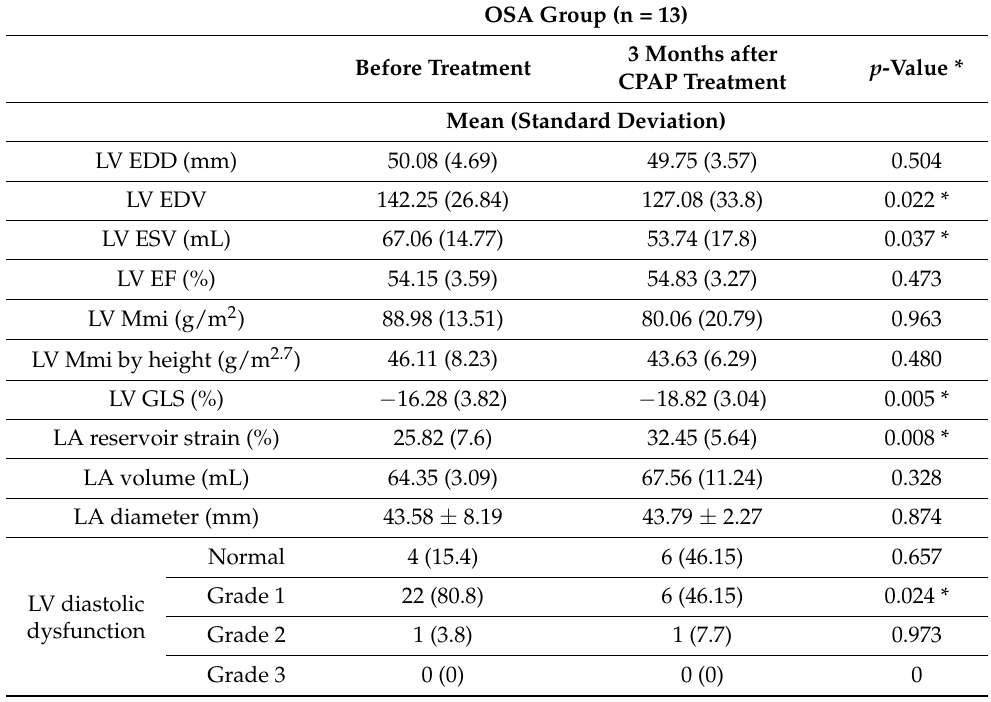
Table 4. Changes in echocardiographic parameters in OSA group patients after treatment with